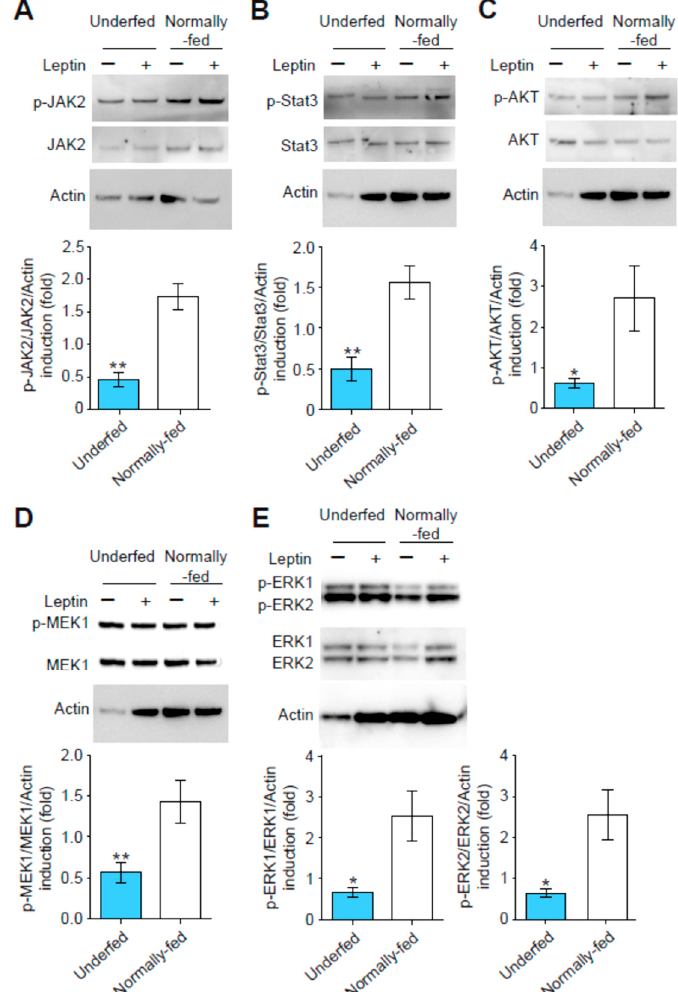
Figure 5. Alterations to leptin-stimulated signaling pathways in arcuate nucleus explants from underfed pups. The activation of the three signaling pathways by the exposure of seven-day explants to leptin (+) for 15 min was different in explants from underfed pups (blue bars) and in explants from normally fed pups (open bars). Data are presented as the fold induction of phosphorylated protein/total protein ratios (normalized against actin) for stimulated relative to unstimulated conditions for ( A ) phosphorylated Jak2/Jak2/actin ( n = 5 per group), ( B ) phosphorylated Stat3/Stat3/actin ( n = 5–7 per group), ( C ) phosphorylated-AKT/AKT/actin ( n = 9 per group), ( D ) phosphorylated MEK1/MEK1/actin ( n = 5–6 per group), ( E ) phosphorylated ERK1/ERK1/actin (left panel) and phosphorylated-ERK2/ERK2/actin (right panel; n = 8 per group). Data are presented as the mean ± SEM, with a Mann–Whitney analysis, with *: p < 0.05, **: p < 0.01.